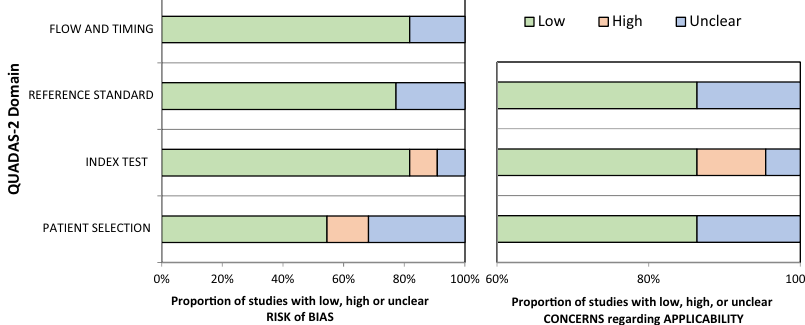
Fig. 4 Risk of bias evaluation according to QUADAS-2 tool. Adapted from the template for graphical display at https://www.bristol.ac.uk/